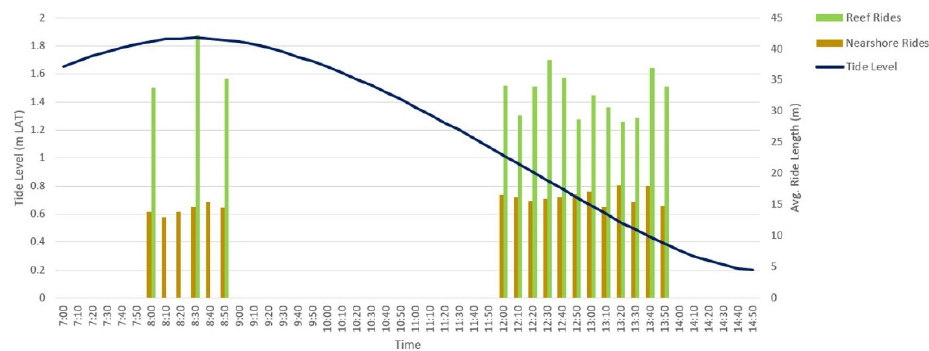
Figure 10. Tide level vs. WPT average ride lengths in the nearshore and reef regions.